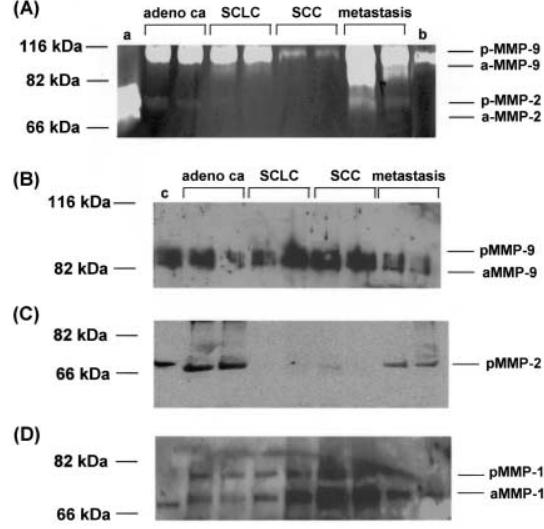
MMP activity and protein expression in bronchial washings obtained from various lung tumours. (A) Representative gelatine zymography for two adenocarcinomas, two small-cell lung carcinomas (SCLC), two squamous-cell carcinomas (SCC) and two pulmonary metastases of extrapulmonary pri- mary tumours. “a” indicates purified human MMP-2, “b” indicates purified human MMP-9. (B) Western-blot analysis of the same bronchial washings analysed in panel 1 A. “c” indicates purified human MMP-9. (C) Western-blot analysis of samples used in panel 1 A for expression of MMP-2 protein, “c” indicates migration of purified human MMP-2. (D) Protein expression analysis by Western blotting for MMP-1 in the same samples as shown in panel 1 A. “c” indicates the purified human